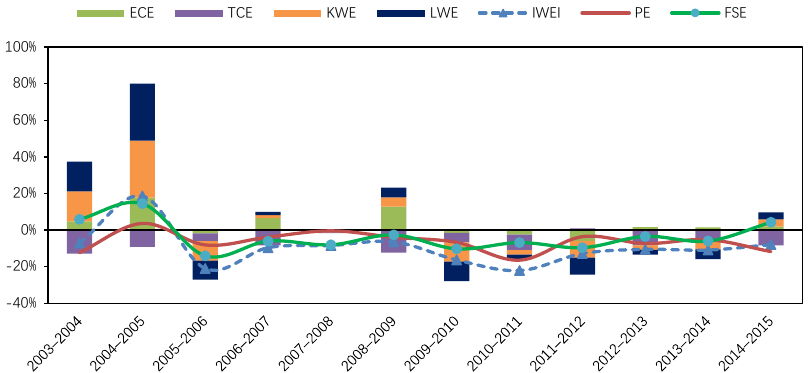
Figure A7. Driving factors of industrial wastewater emission intensity change in the Southwest Area, 2003–2015. ECE: the effect of technical efficiency change; TCE: the effect of technological change; KWE: the effect of capital – wastewater substitution; LWE: the effect of labor – wastewater substitution; IWEI: industrial wastewater emission intensity; PE: productivity effect; FSE: factor substitution effect. Int. J. Environ. Res. Public Health 2018 , 15 , x